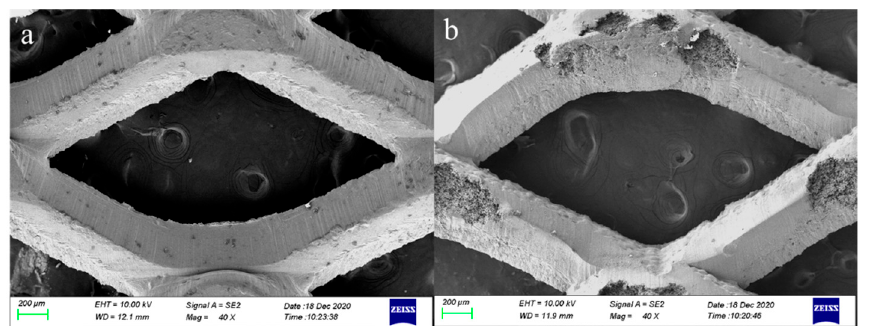
Figure 7. SEM results of the Al electrode in this study, ( a ) the original electrode, and ( b ) the electrode after the operation.